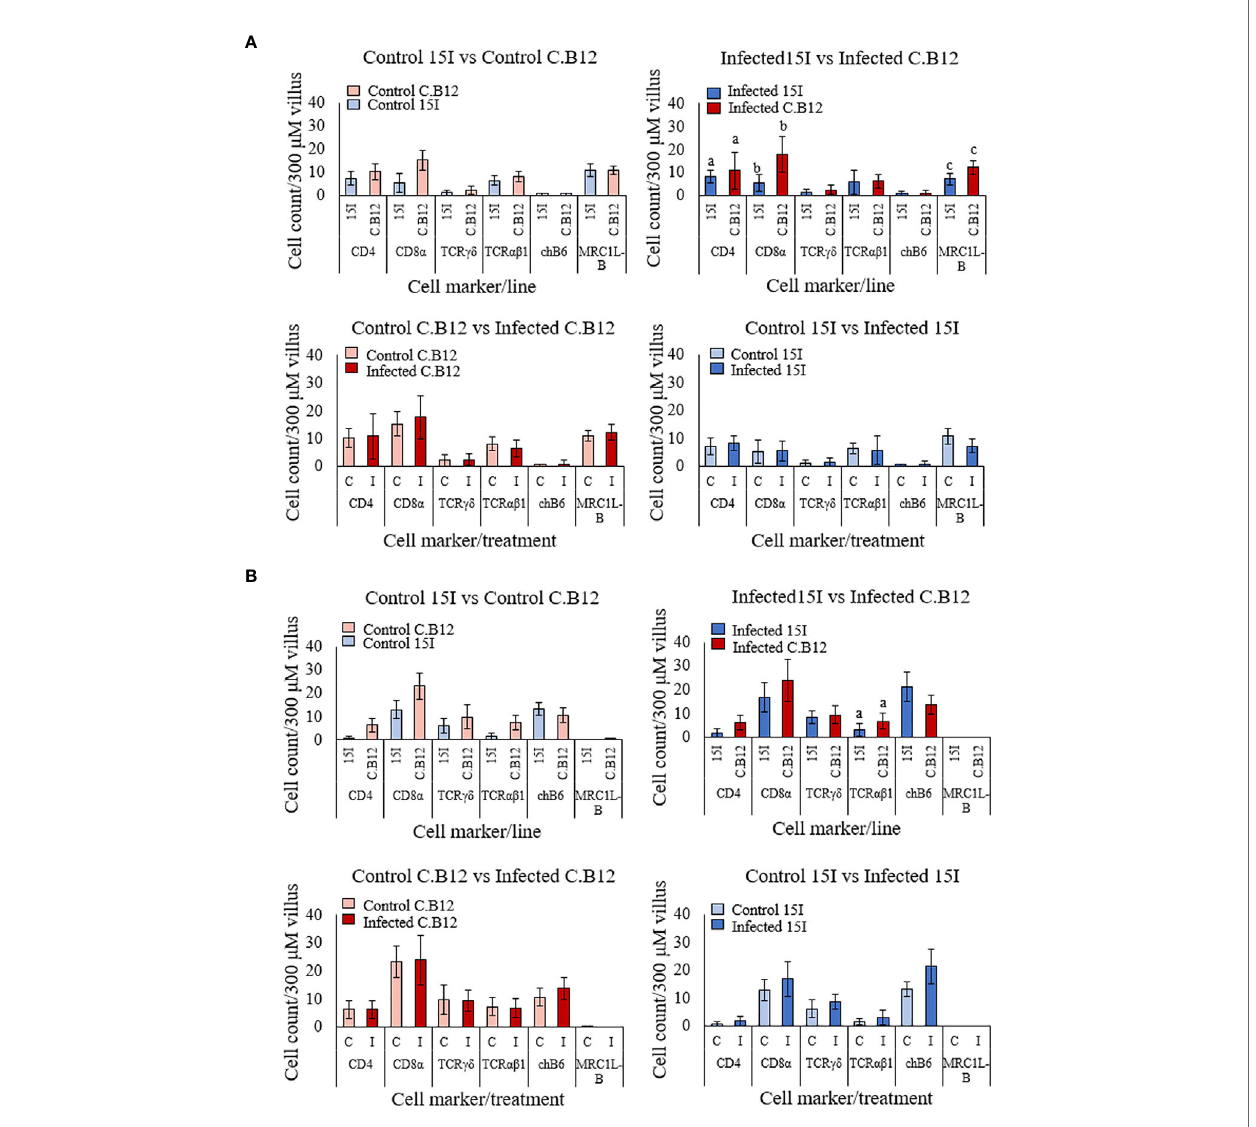
FIGURE 7 | Populations of CD4, CD8 a , gd T cells, ab 1 T cells, chB6 and MRC1L-B LPL (A) and IEL (B) in the jejunal villi of line C.B12 and line 15I chickens at 4 dpi with E. maxima . Shown are data comparing control birds of both lines, infected birds of both lines, control and infected line C.B12 birds and control and infected line 15I birds. LPL and IEL were counted from nine villi of one section per bird ( n = 3 for uninfected and n ≥ 5 for infected groups). Each bar represents the mean number of cells per 300 m m of villus (± SD). Matching letters denote signi fi cant differences between groups ( p < 0.05). C, Control; I,